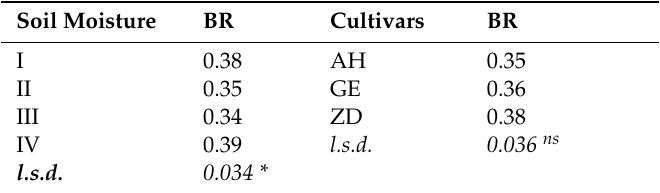
Table 5. Mean branching ratio (BR) under various soil moisture (See Table 1 for soil moisture abbreviations) and cultivar (AH, GE and ZD) treatments. * p < 0.05; ns-no significant.